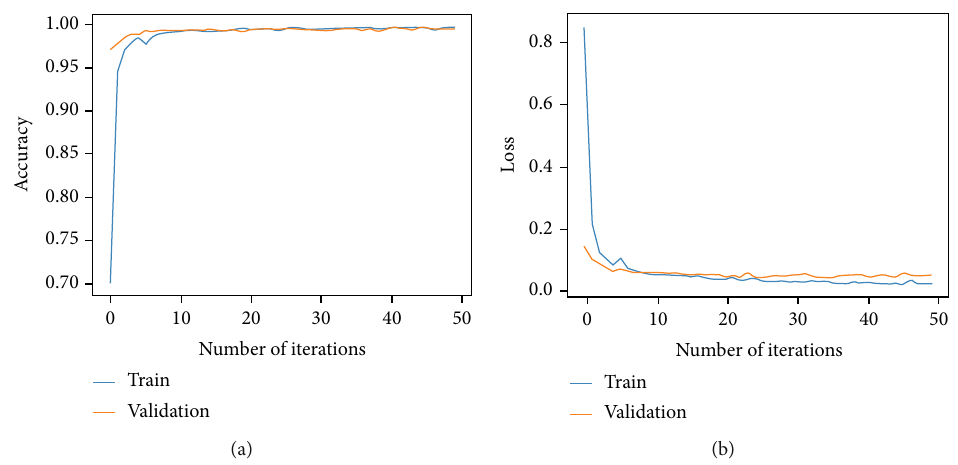
Figure 5: Model accuracy and loss curves for RTD dataset. (a) Accuracy over iterations. (b) Loss over